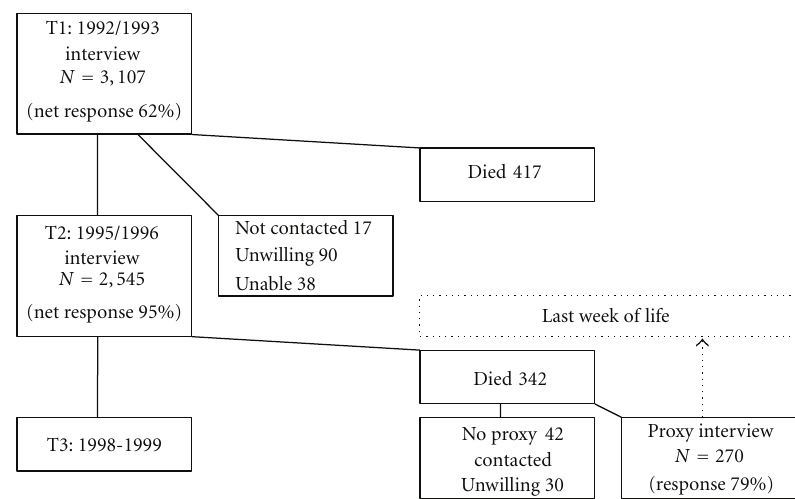
Figure 1: Flowchart of sampling times of the proxy interviews of deceased respondents of the Longitudinal Aging Study Amsterdam between